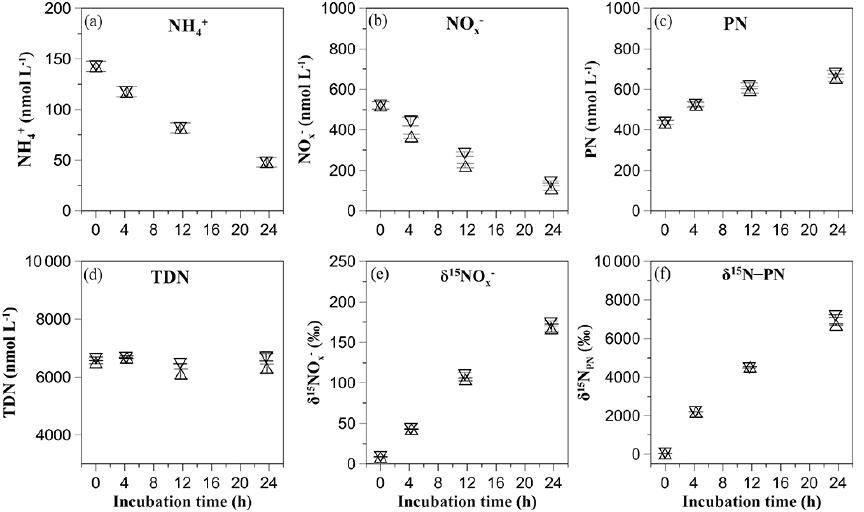
], (b) [NO − x ], (c) [PN], (d) [TDN], (e) δ 15 N-NO − x , and (f) δ 15 N-PN. 4